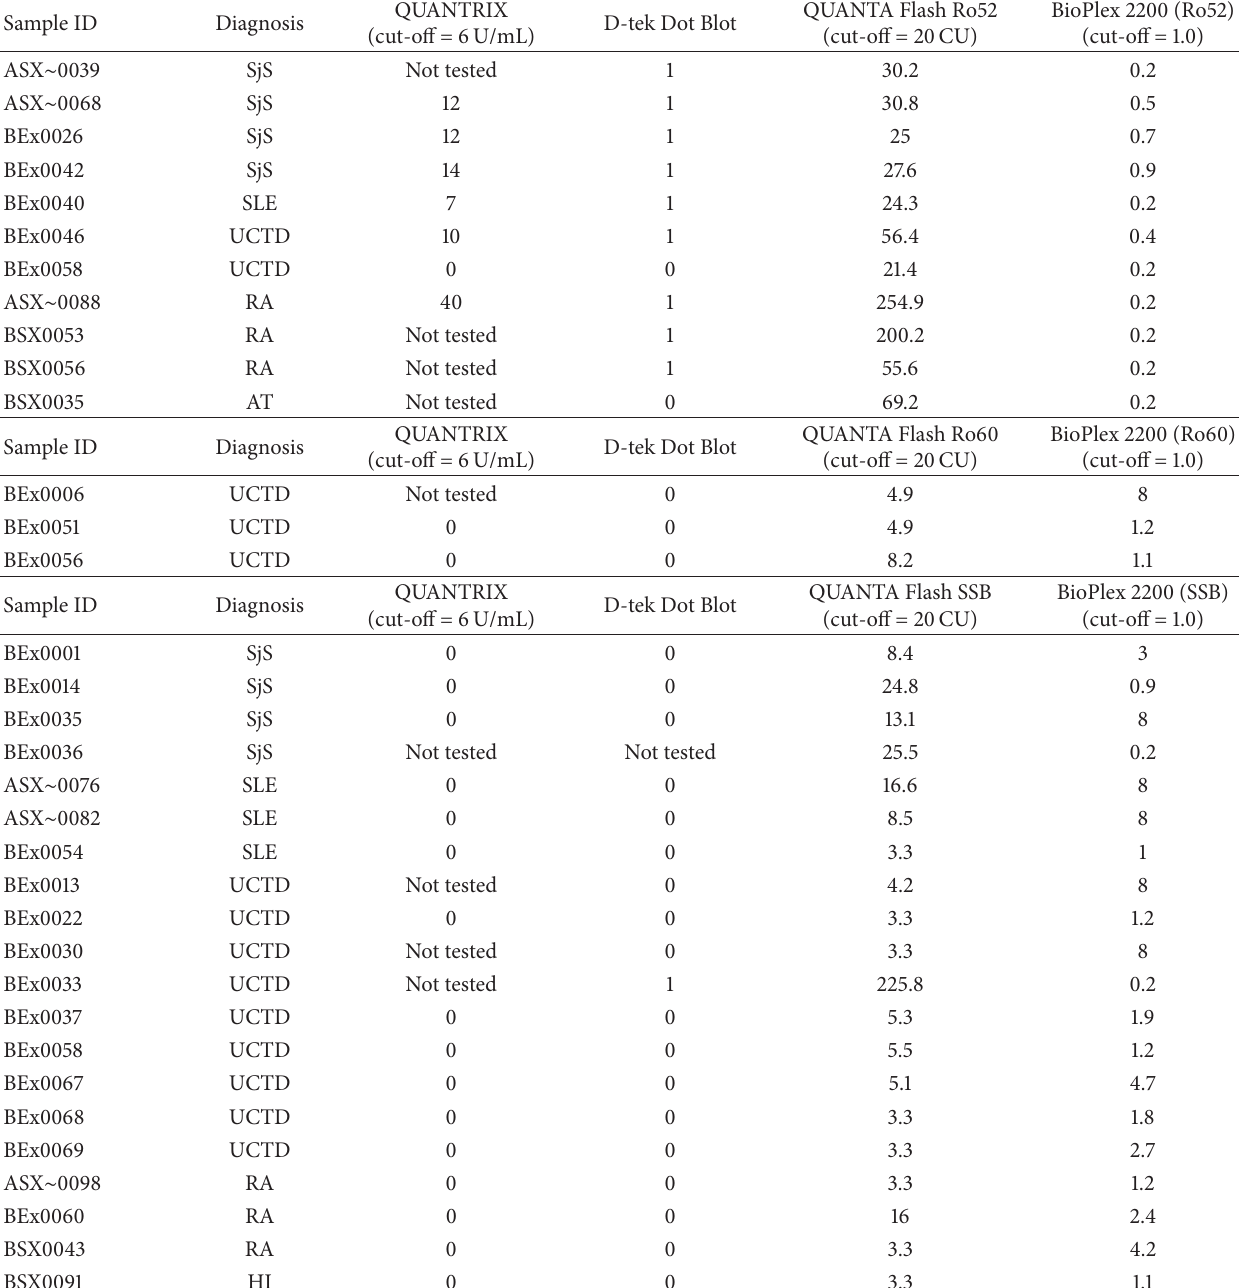
Table 3: Overview of discrepant samples sorted according to disease